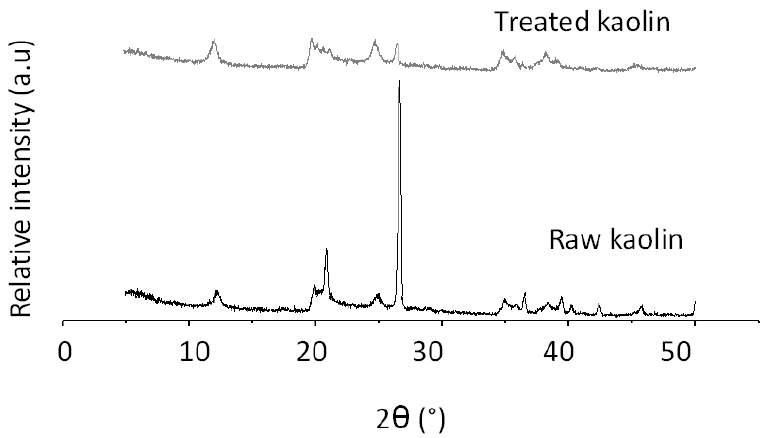
Figure 1. XRD pattern of raw kaolin and treated kaolin. Table 1. Variations in composition of the Indonesian kaolin before and after treatment.